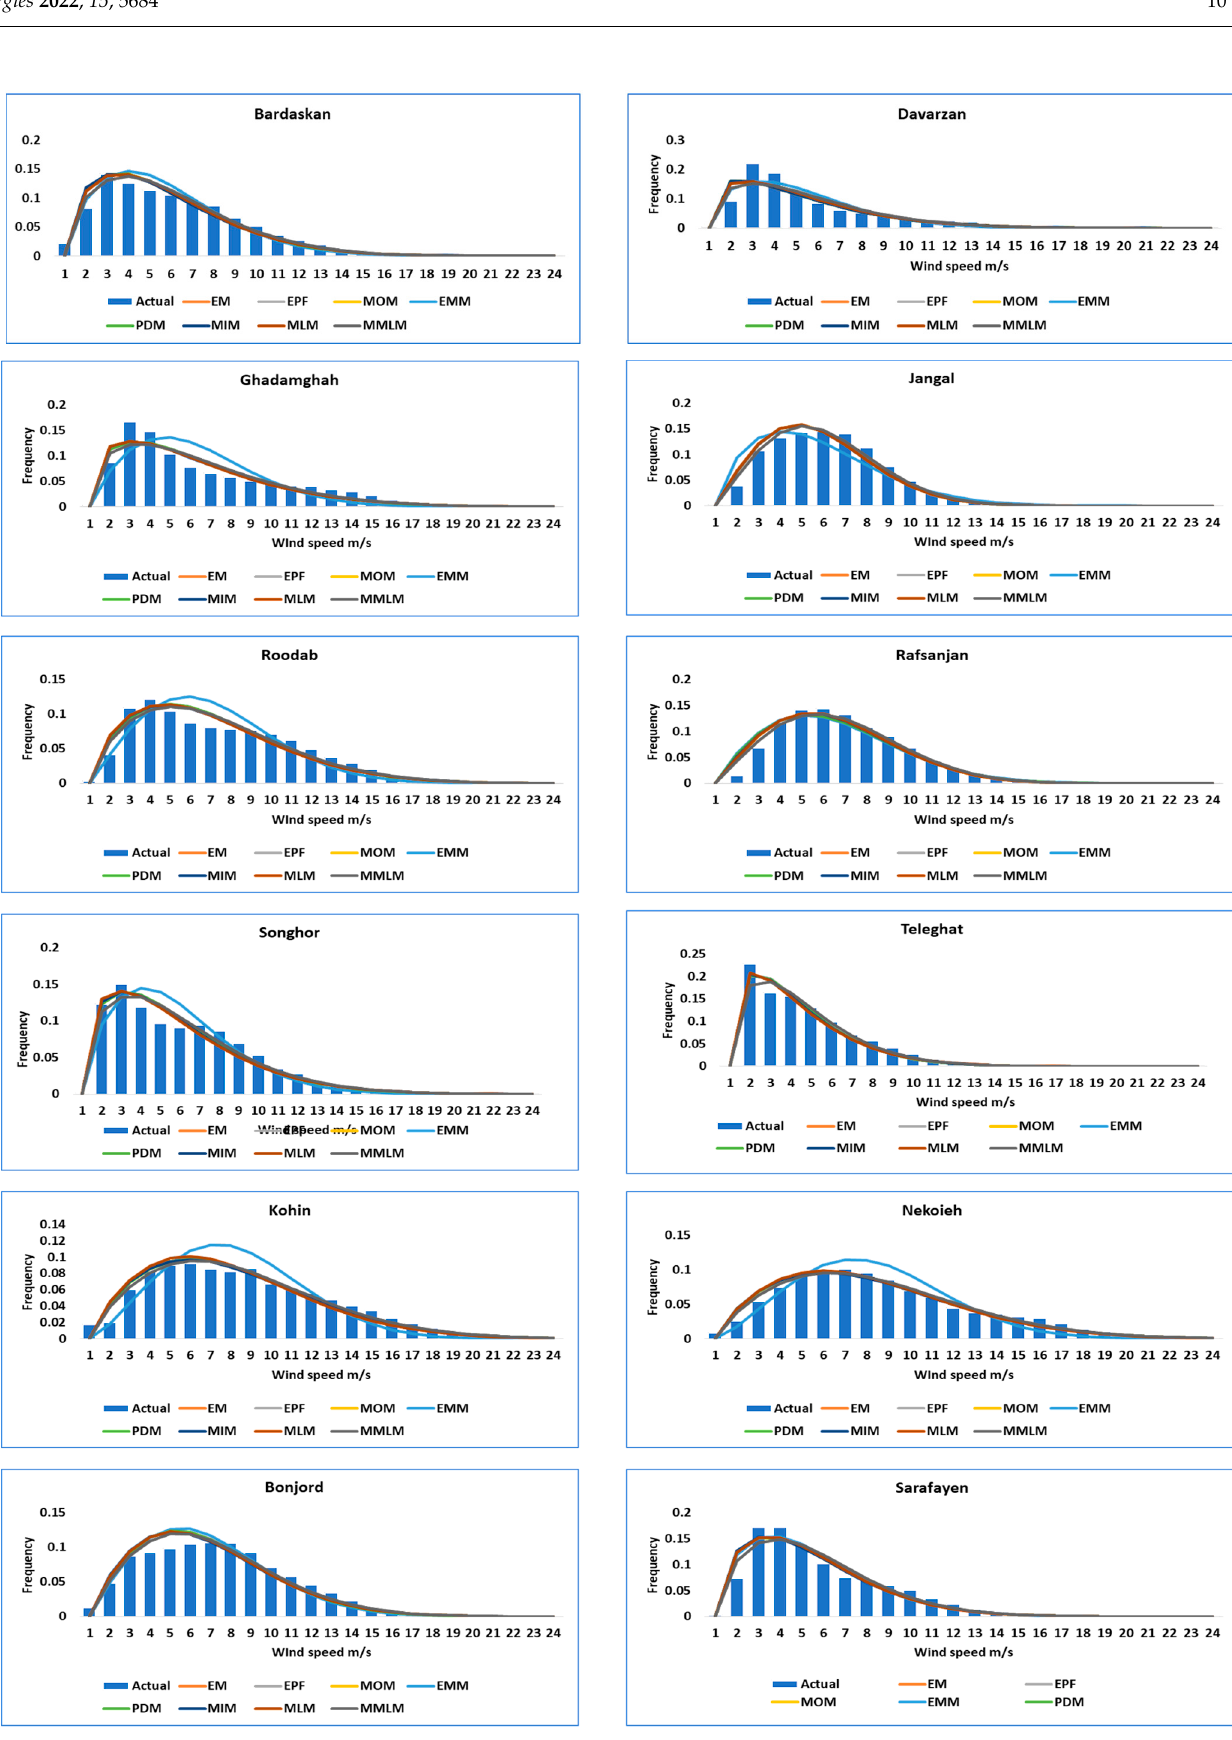
Figure 2. Weibull probability distribution of the sites.